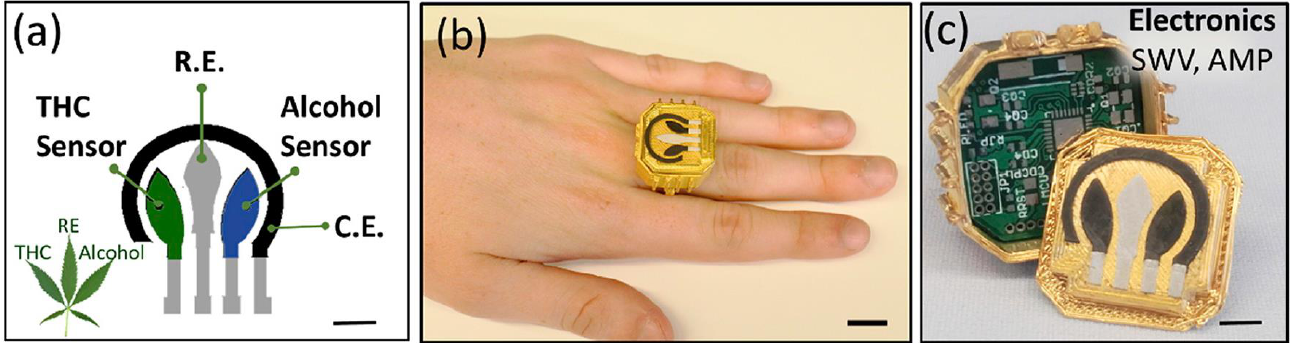
Figure 4 . ( a ): The leaf-like sensor configuration, including dual working electrodes with the same counter electrode (C.E.) and reference electrode (R.E.). ( b ): Wearable electrochemical ring sensor.